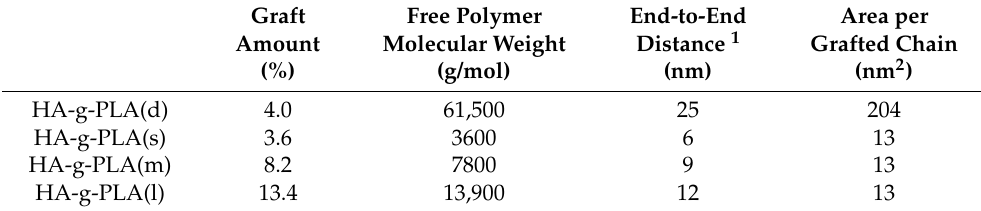
Table 1. Quantitative analysis of HA-g-PLA.